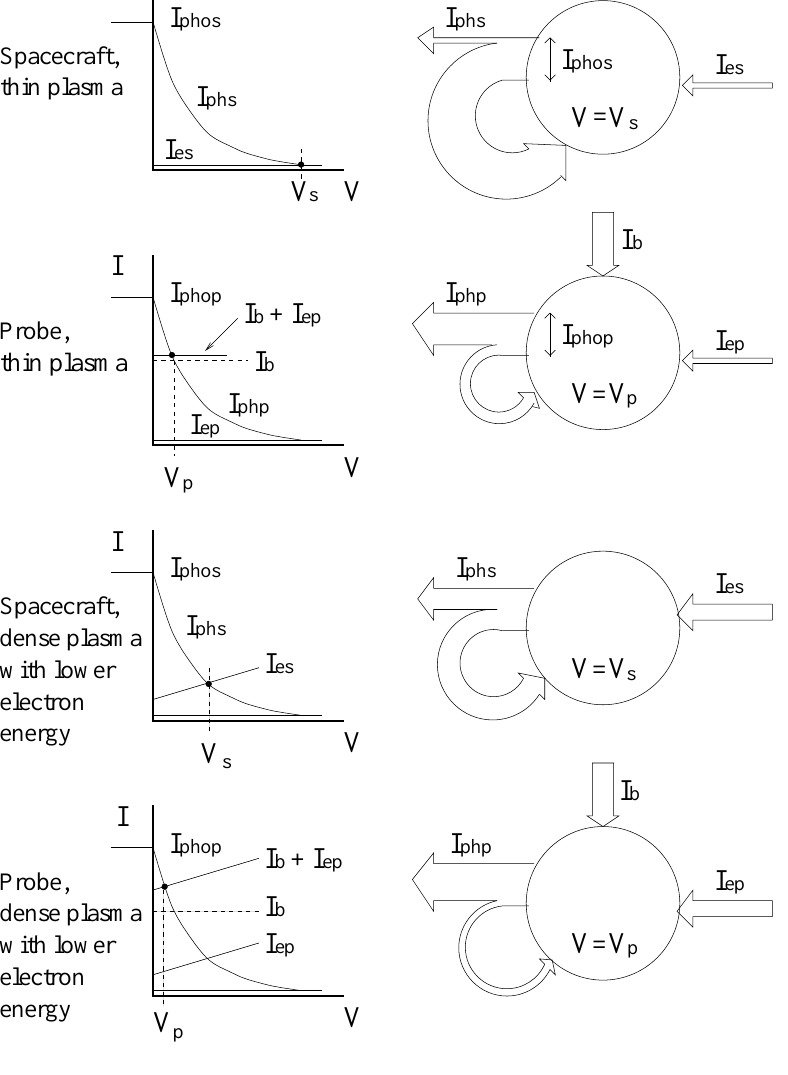
Fig. 1. Schematic illustrations of the spacecraft and probe current balance between photoelectrons escaping to the plasma and electrons collected from the plasma. For the probe, a bias current ( I b ) forces electrons to the probe in- dependent of probe voltage. I phos and I phop are spacecraft and probe photo- electron saturation currents. I phs and I php are spacecraft and probe photo- electron currents as functions of, re- spectively, spacecraft potential ( V s ) and probe potential ( V p ). I es and I ep are spacecraft and probe electron currents as functions of, respectively, V s and V p